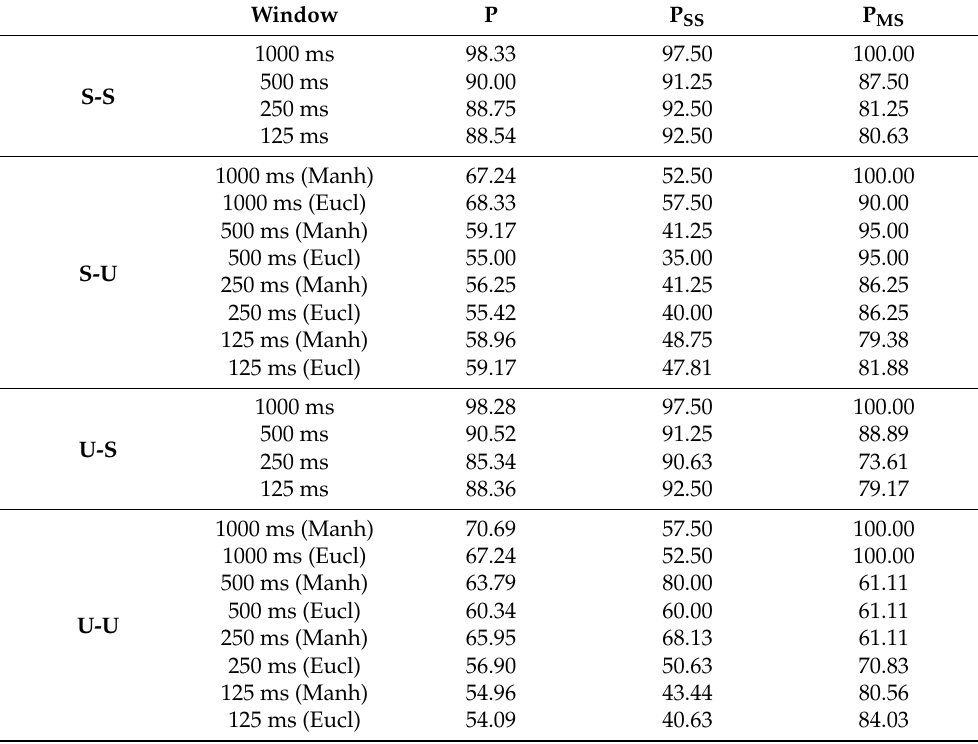
Table 6 exhibits the discrimination rates for the SM scheme. Table 6. Classification performances for SM